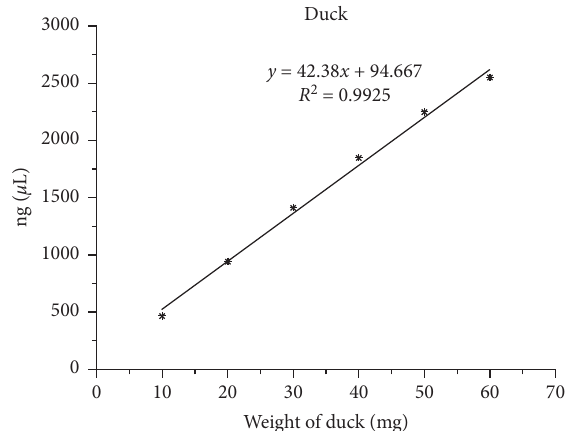
Figure 5: The relationship between the DNA content and the copy number of duck